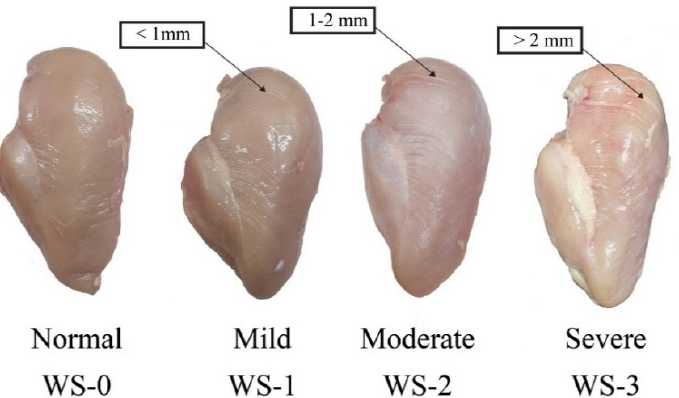
Figure 2. Visual scoring scale for white striping (WS) in pectoral muscle where 0 = normal, 1 = mild, 2 = moderate, and 3 = severe. Normal—No distinct white lines. Mild—Small white lines, generally <1 mm thick, but apparently visible on the breast surface. Moderate—Large white lines (1–2 mm thick) very visible on the breast surface. Severe—Thick white bands (>2 mm thickness) covering almost entire surface of breast.